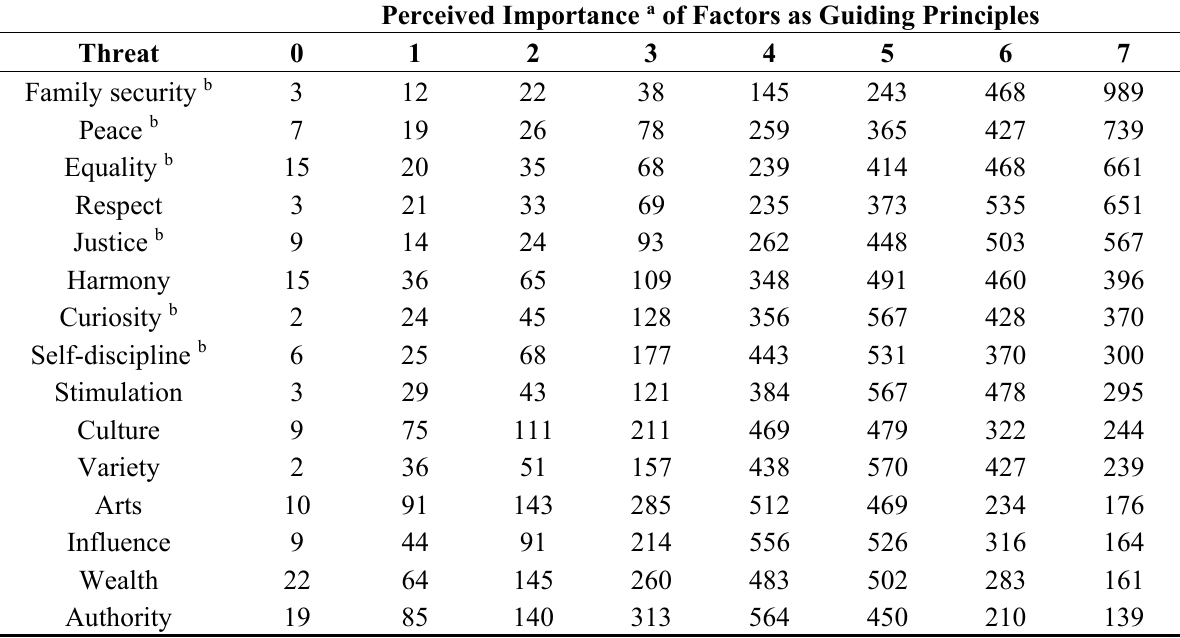
Table 1. Perceived importance of modified Schwartz brief scale value